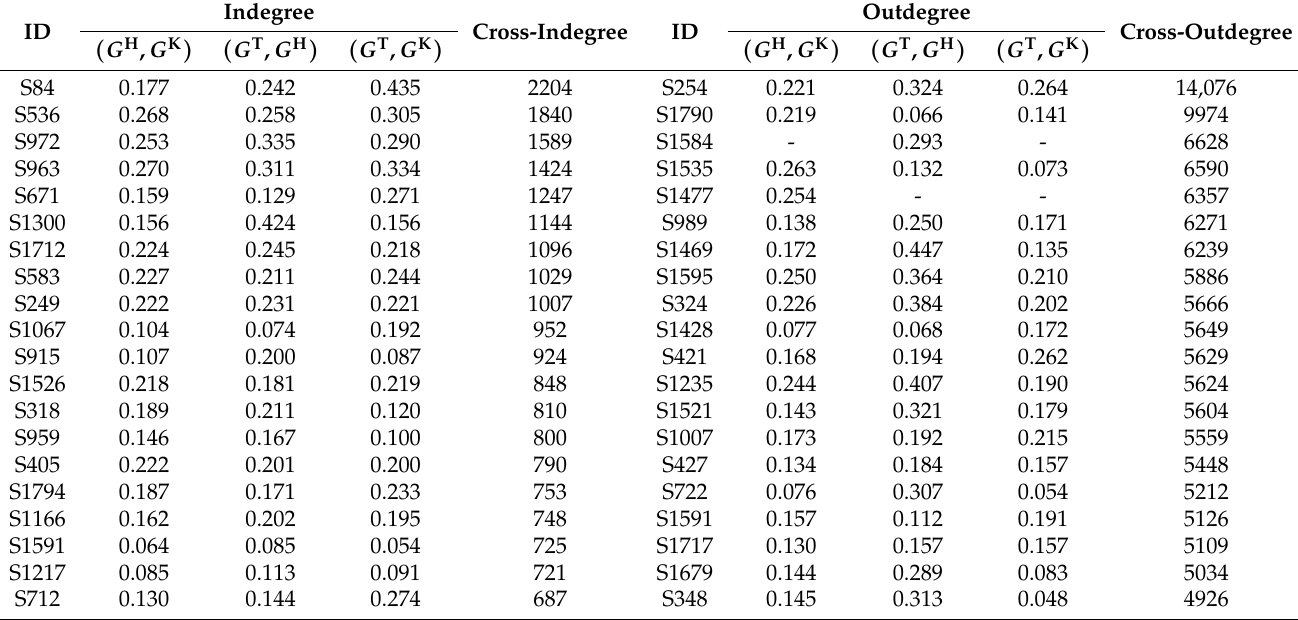
Table 5. Indegree and outdegree similarities of the top 20 influential malicious